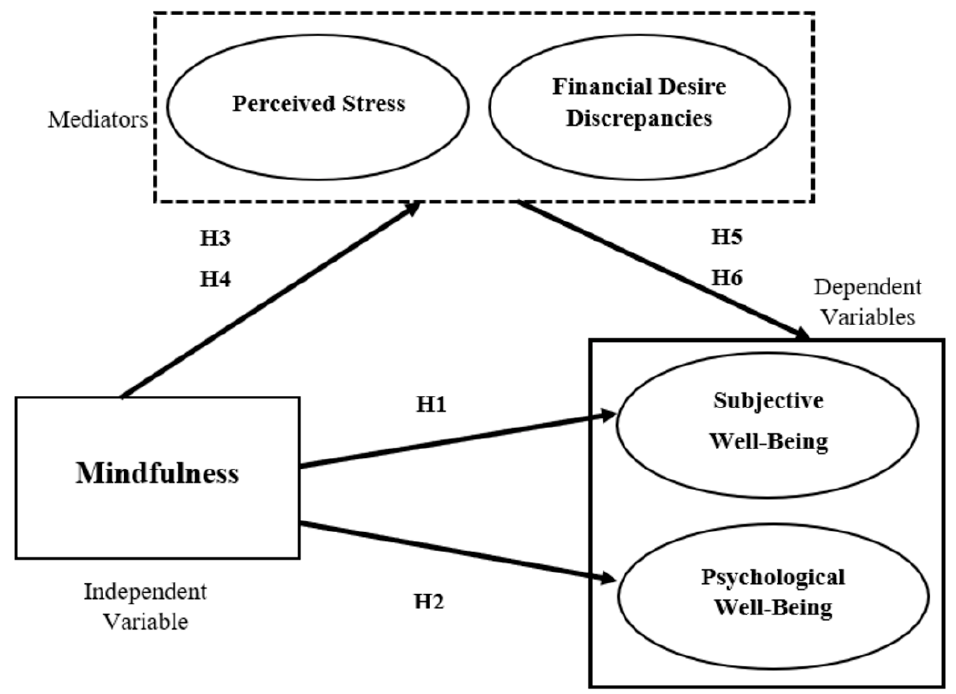
Figure 1. Conceptual